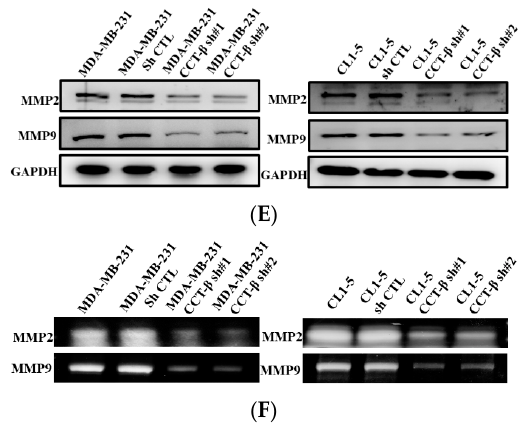
Figure 7. CCT- β knockdown suppressed EMT-related proteins and MMP2/9 in MDA-MB-231 and CL1-5 cells. ( A ) CCT- β knockdown and overexpression of CCT- β in CCT- β knockdown cells induced